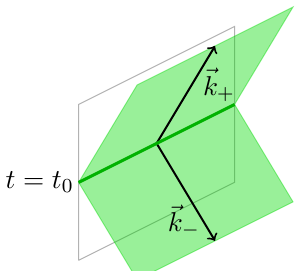
Figure 3 . The Wheeler-DeWitt patch corresponding to some constant boundary-time slice t = t 0 . The radial NEC corresponding to the null vectors ~k ± produces a monotonic a